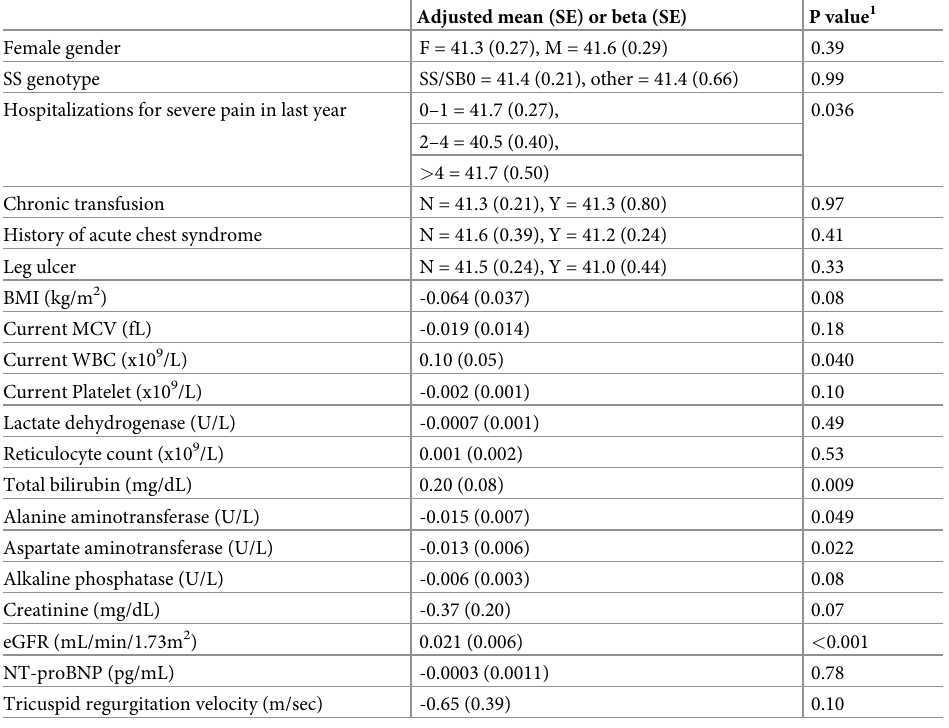
Table 2. Age and hemoglobin adjusted association between serum albumin and sickle cell clinical variables in adults with sickle cell disease in validation cohort (OMG).